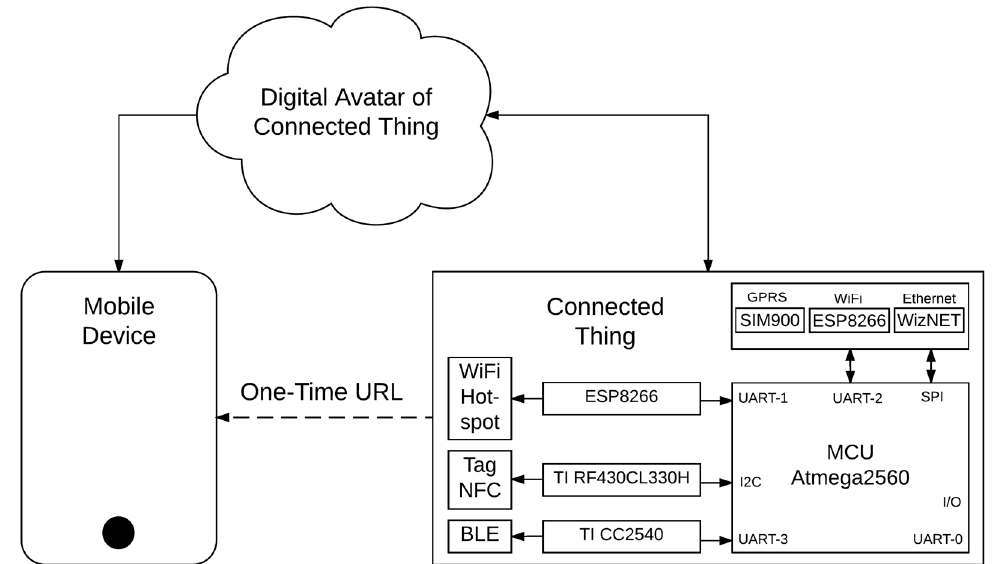
Figure 2. Short range wireless technologies available on smartphones.